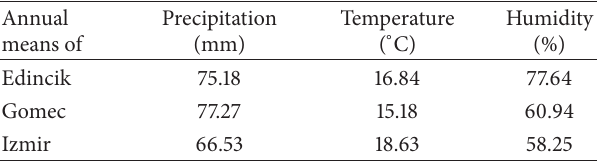
Table 1: Climatic conditions of the growing